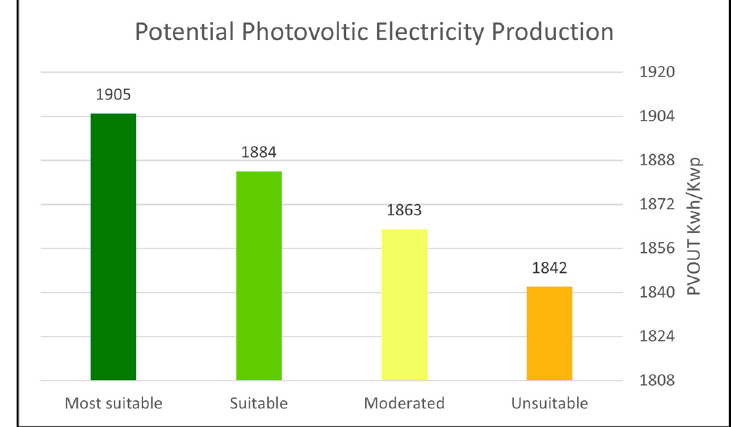
Figure 11. The average production of energy in each suitability